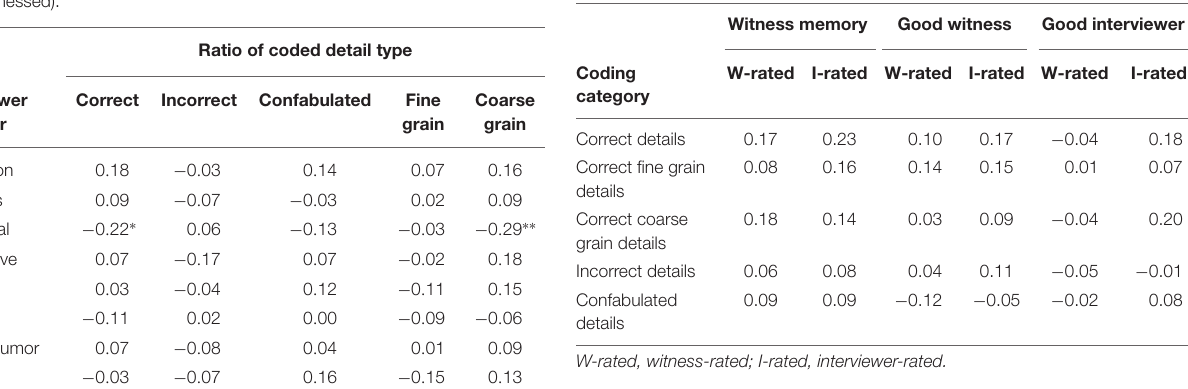
TABLE 5 | Partial point biserial correlations between coded details and presence of interviewer behavior (controlling for witness, interviewer, practice effects, and event witnessed).